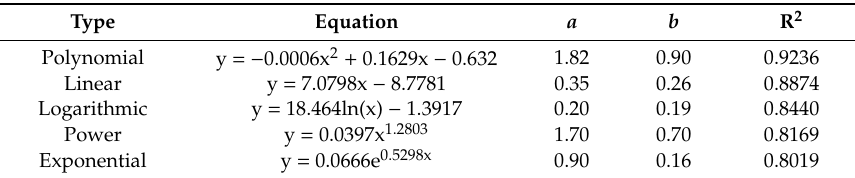
Table 2. The highest correlation coe ffi cient of various equations model and the values of a and b involved are when m is 1.02 and n is 0.03. Figure 1. ( a ) Scope of Ordos Basin in China; ( b ) location of Hangjinqi area in Ordos Basin; ( c ) stratigraphic sequence; ( d ) glutenite in the He3 member of the JX well, depth 3047.65–3047.77 m; ( e ) glutenite in the He3 member of the JX well, depth 3053.42–3053.68 m.